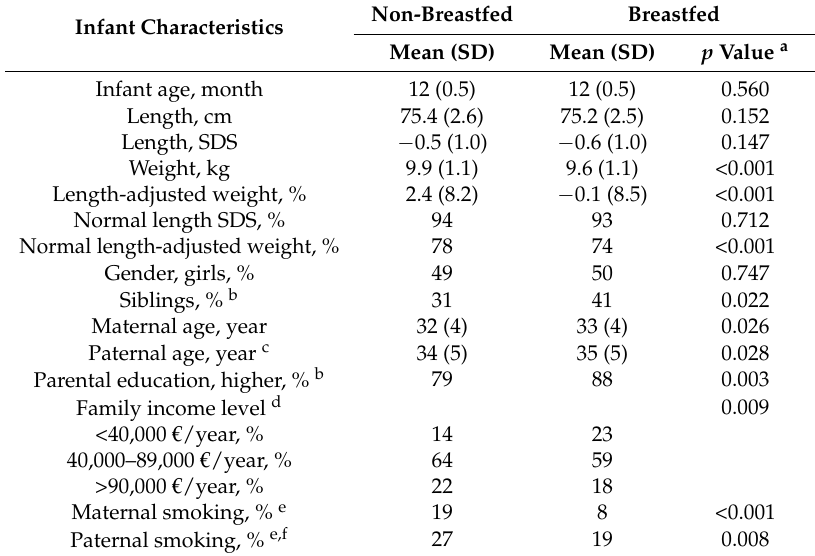
Table 1. Characteristics of non-breastfed ( n = 476) and breastfed ( n = 263) 1-year-old infants. Infant